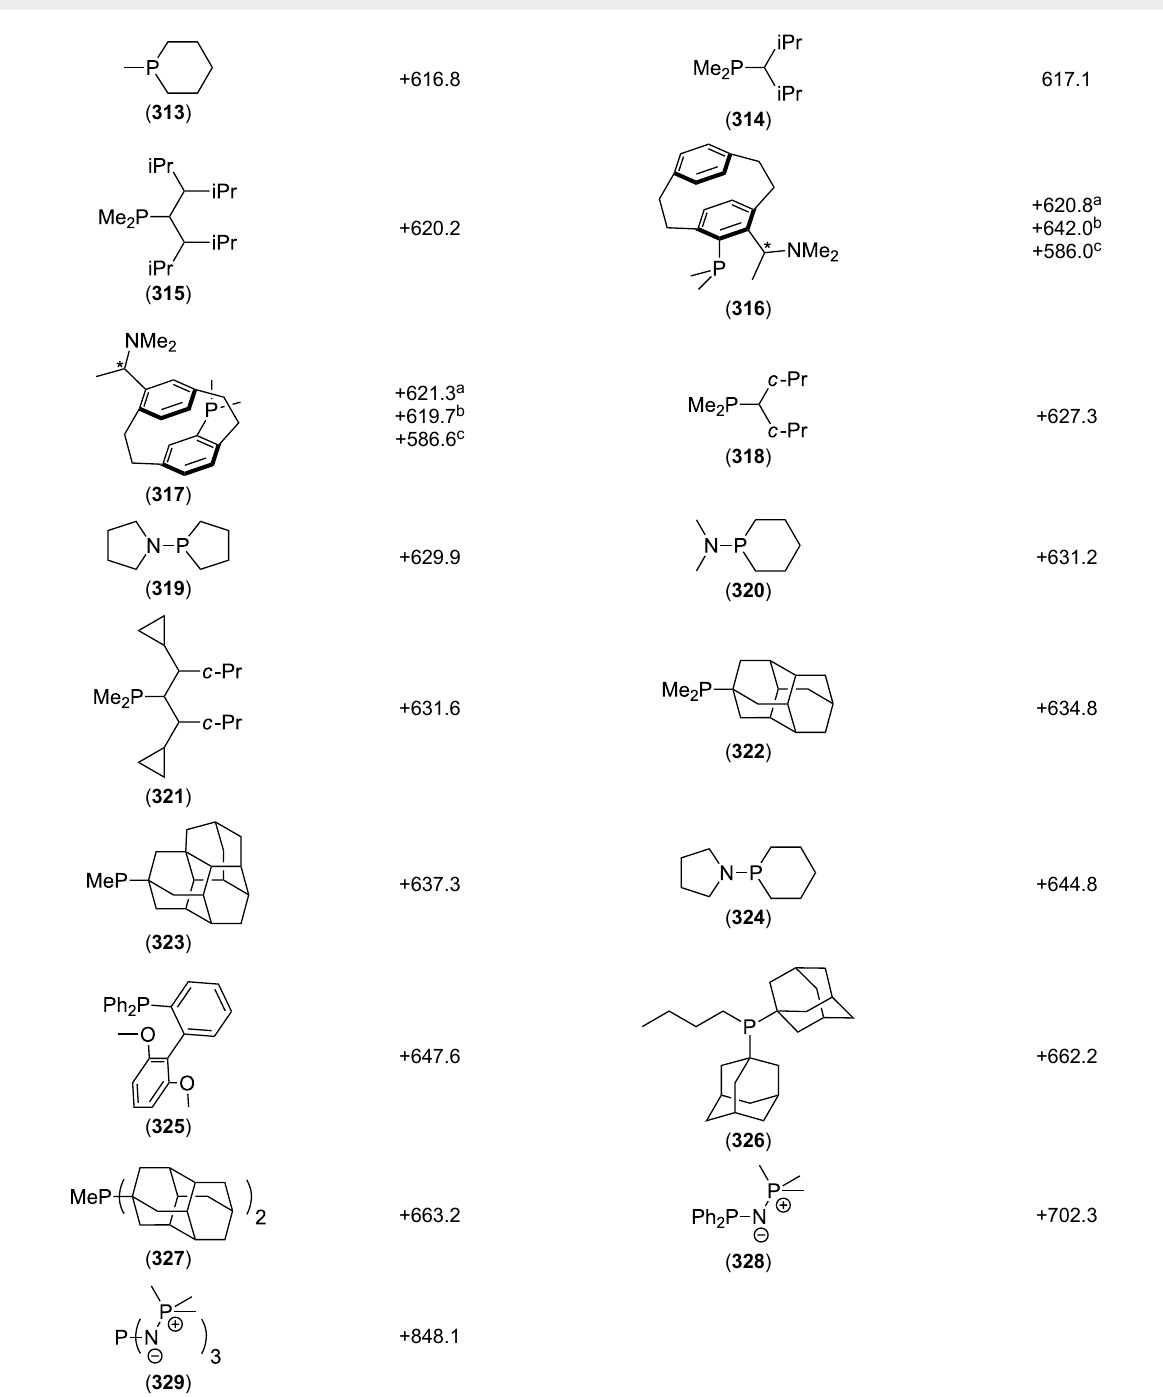
Table 7: MCA values of miscellaneous phosphanes, ordered by increasing MCA values.